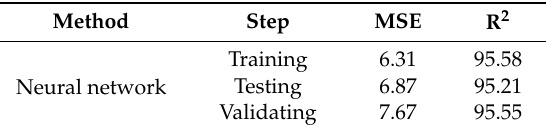
Figure 8. Number of iterations (epochs) versus mean square error (MSE).